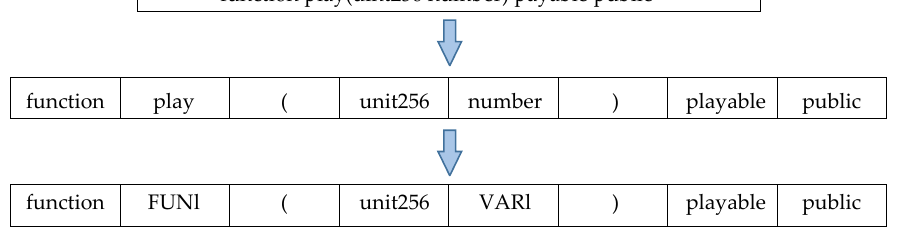
Figure 8. Symbol representation process.